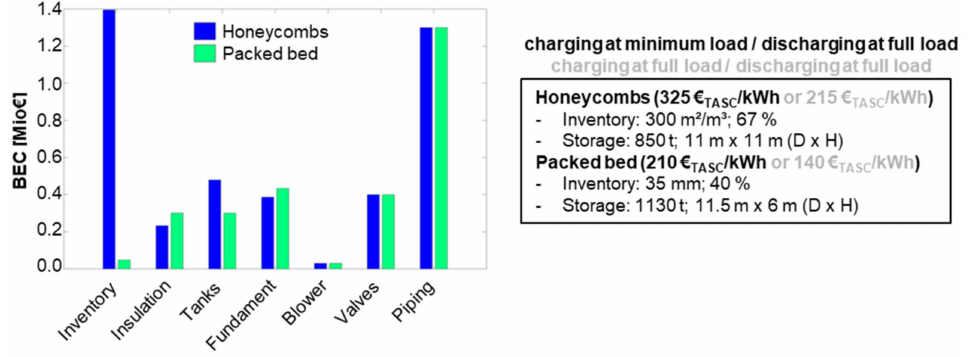
Figure 18. Detailed variation calculations for the storage option “solid media heat storage” (concept Flue gas-Air_indirectly)